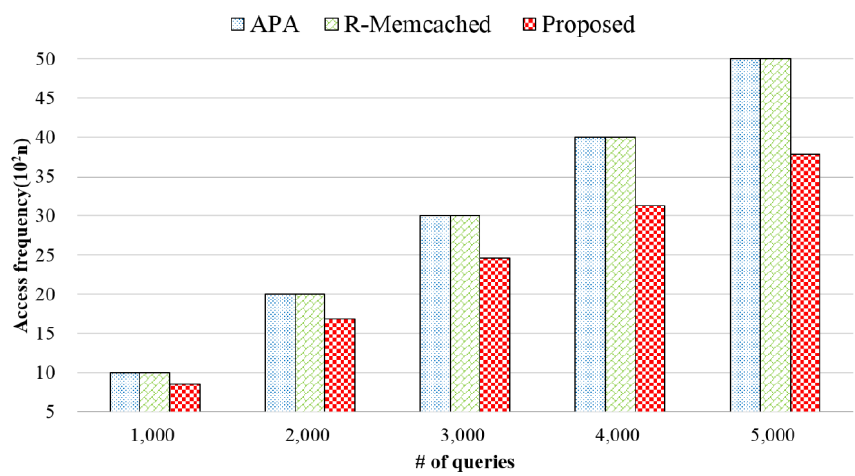
Figure 17. Load balancer access frequency according to the number of query requests.